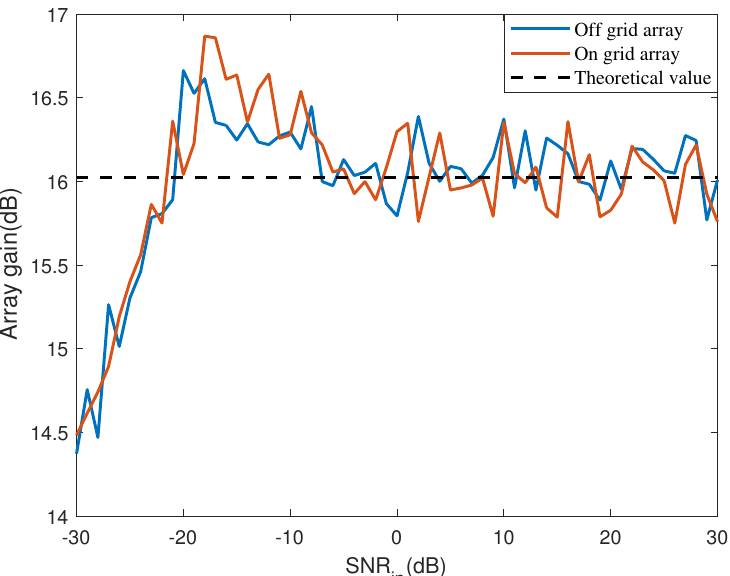
Figure 20. Curve of the radiation impedance changing with the array element spacing.